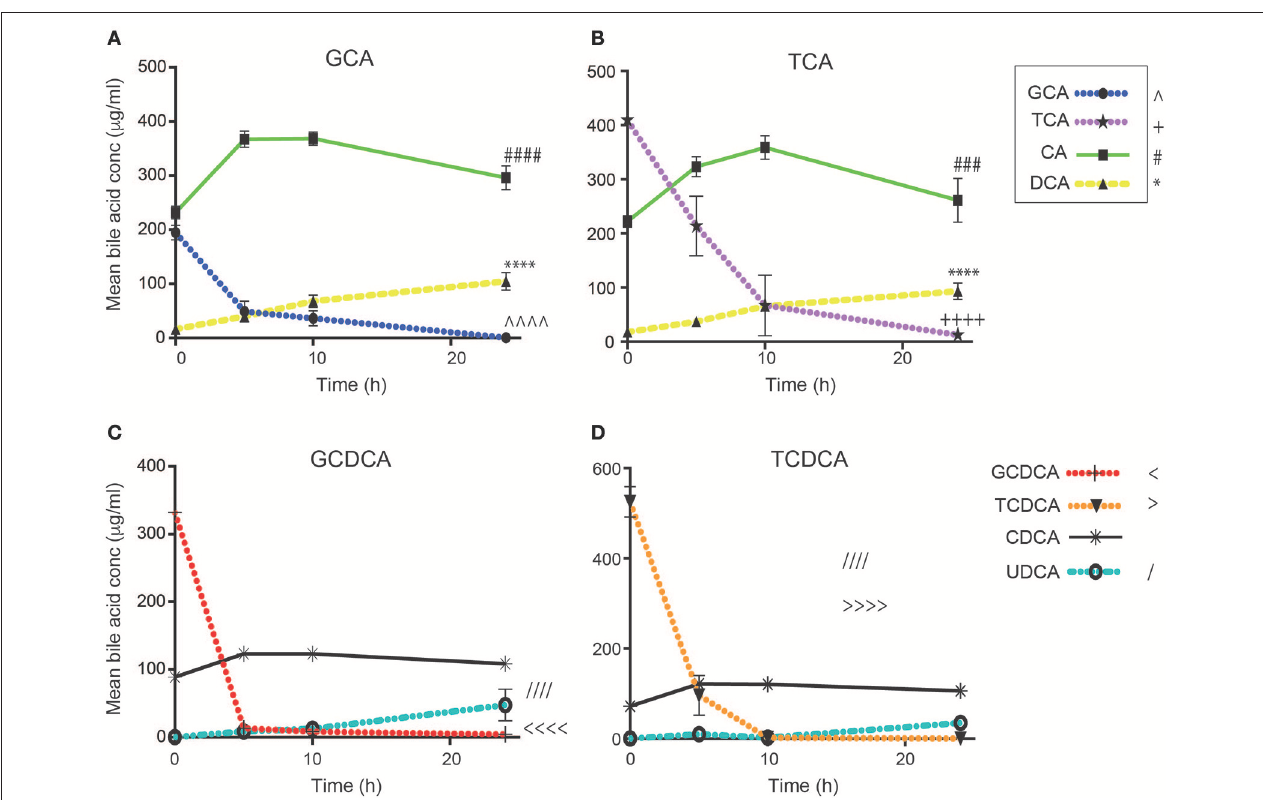
FIGURE 2 | Bile acid concentrations over 24h following the addition of (A) glycocholic acid (GCA), (B) taurocholic acid (TCA), (C) glycochenodeoxycholic acid (GCDCA), and (D) taurochenodeoxycholic acid (TCDCA) to human fecal batch cultures ( n = 7). Values are mean expressed in µ g/ml ± SD. Significant time-dependent differences were observed in the concentrations of the individual bile acids using a one-way ANOVA. (A) ∧∧∧∧ GCA p < 0.0001, #### CA p < 0.0001, **** DCA p < 0.001. (B) ++++ TCA p < 0.0001, ### CA p = 0.004, ****DCA p < 0.001. (C) <<<< GCDCA p < 0.0001, //// CDCA p < 0.0001. (D) >>>> TCDCA p < 0.0001, //// CDCA p < 0.0001. CA, cholic acid; DCA, deoxycholic acid; UDCA, ursodeoxycholic acid.